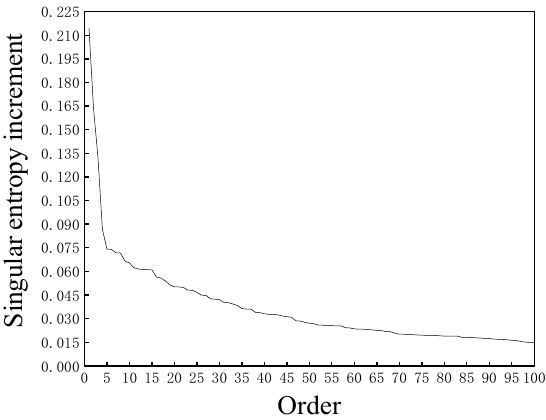
Figure 12. Singular entropy-increment curve.